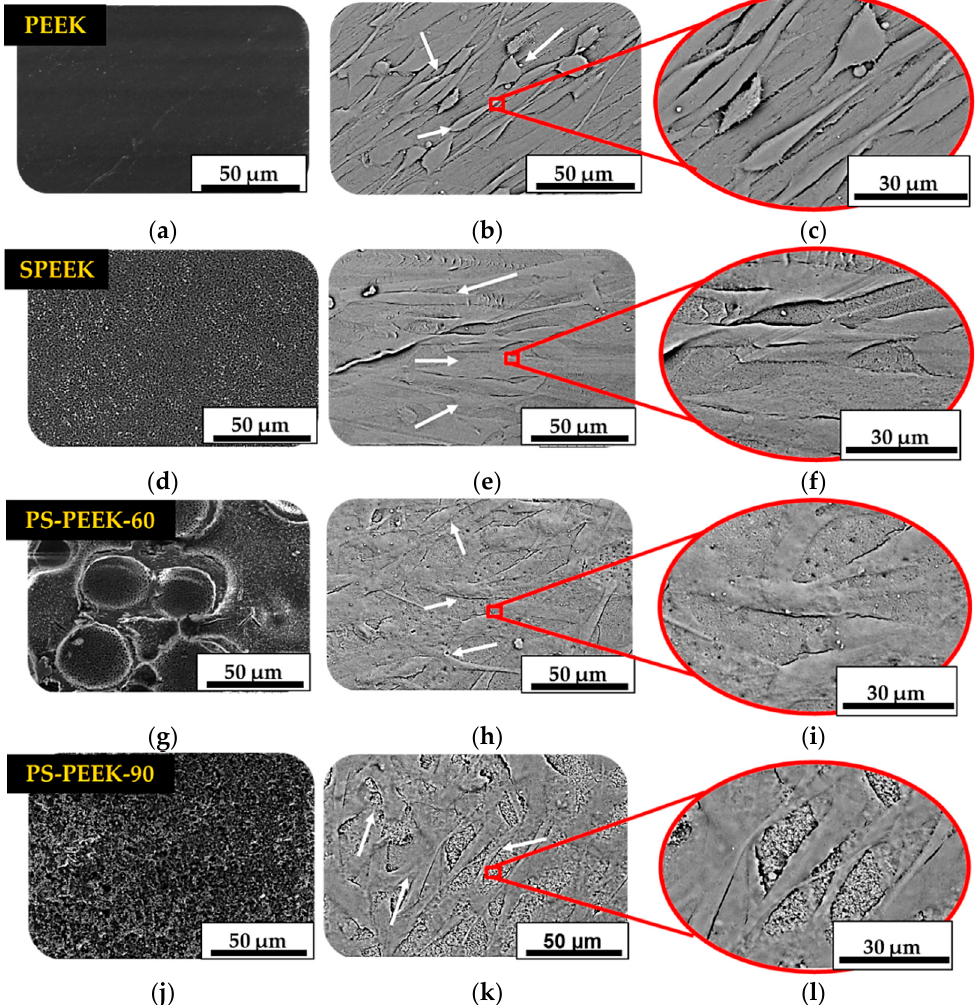
Figure 6. SEM micrographs of PEEK ( a – c ), SPEEK ( d – f ), PS-PEEK-60 ( g – i ) and PS-PEEK-90 ( j – l ) surfaces before and after cell adhesion and proliferation after 7 days.